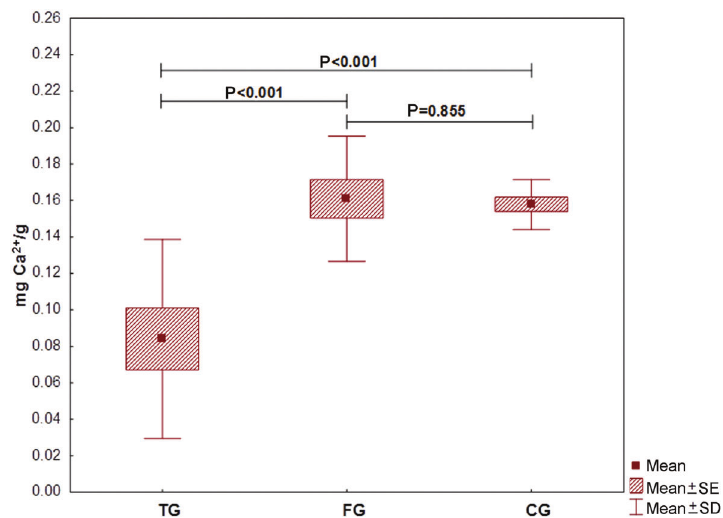
Figure 3. Comparison of the amount of calcium among groups. Data are reported as averages, standard deviation and maximum and minimum errors. TG: transcutaneous electrical nerve sti- mulation (TENS) group; FG: functional electrical stimulation (FES) group; CG: control group. The LSD test was used for statistical analysis (P o